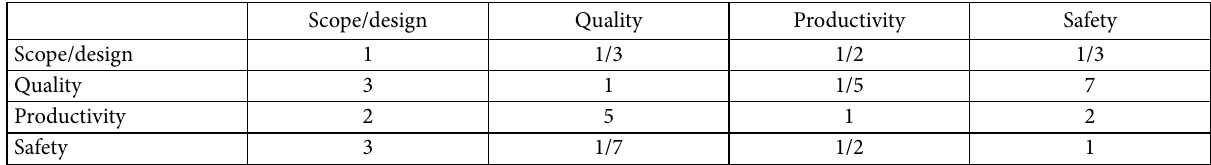
Table 4. An example of comparison matrix for “construction”